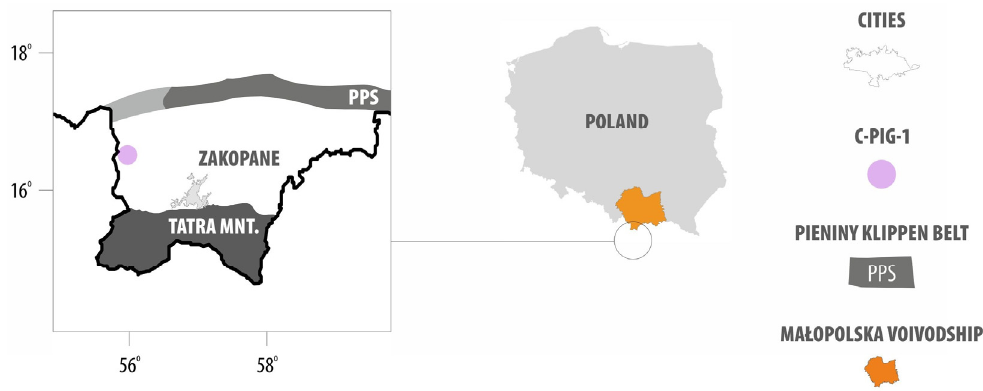
Figure 3. Location of the C-PIG-1 geothermal well.